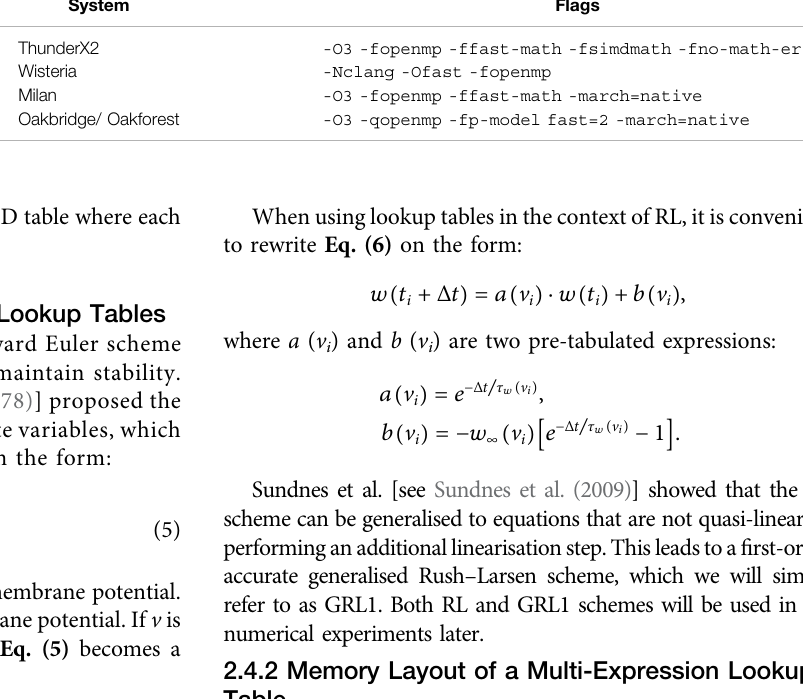
A lookup table containing M expressions evaluated at S points,